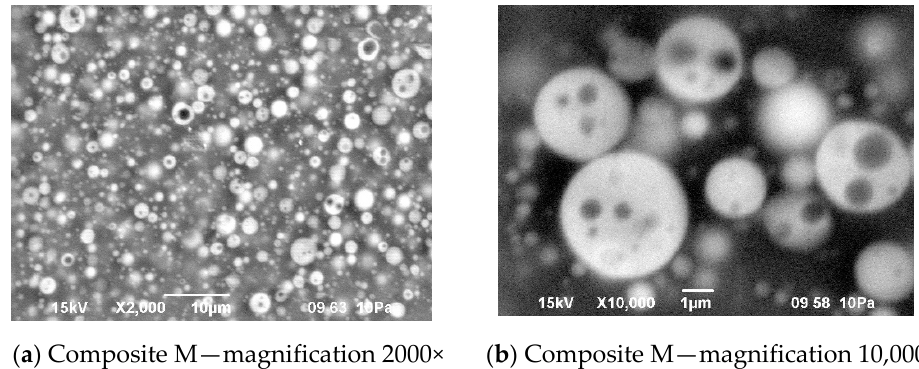
Figure 12. Morphology of the composite film M prepared using reactive IL (IL 3) to dissolve prepolymer ( a ) and non-reactive IL (IL 5) to dissolve lithium salt ( b ).